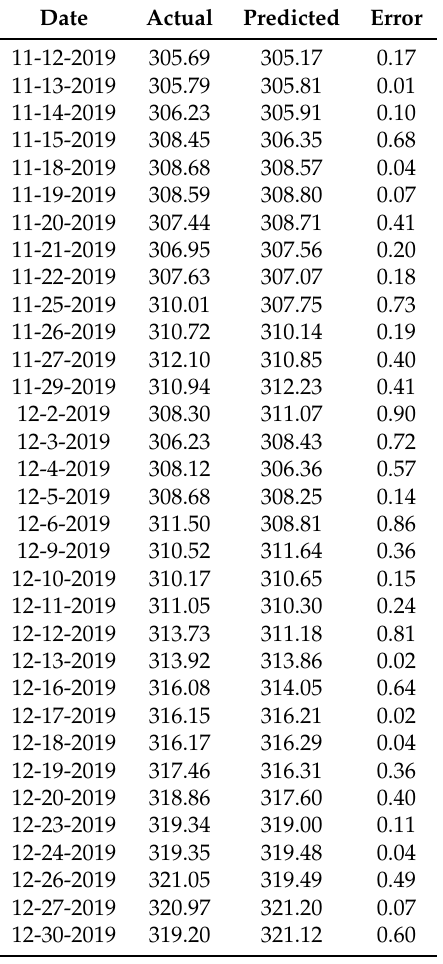
Table 4. Prediction by ARIMA(0,2,1) model.